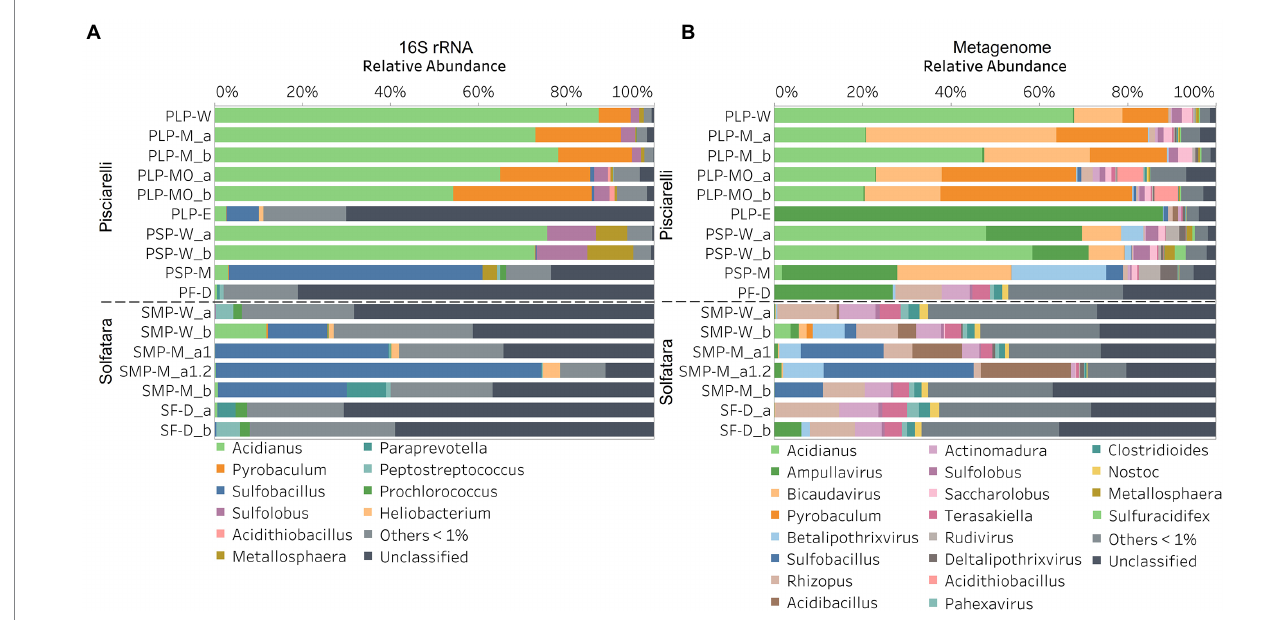
FIGURE 4 Relative abundance of genera based on (A) metagenome-derived 16S rRNA gene and (B) metagenomic profiling. Relative abundance was calculated after removing sequences that were unclassified at the domain level, kitome, singleton, species present in only one sample and low abundance species. Genera with average abundance of <1% were grouped into Others <1%. W represents water, M for mud, MO for mud outlet, E for epilithic microbial layer from dry mud, and D for fumarolic deposits samples. Samples labeled a and b are replicates sampled from the same spot. Sample SMP-M_a1 and SMP-M_a1.2 are sequencing